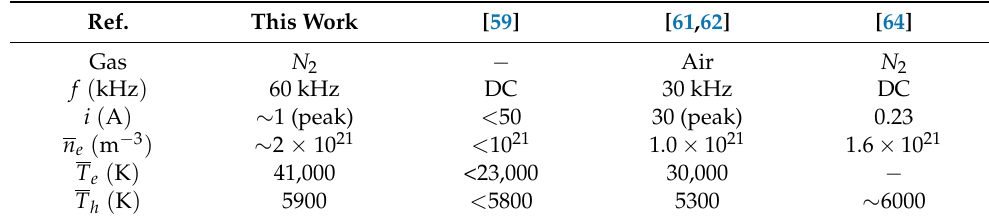
Table 1. Comparison of the scattering results with the most relevant reference values.